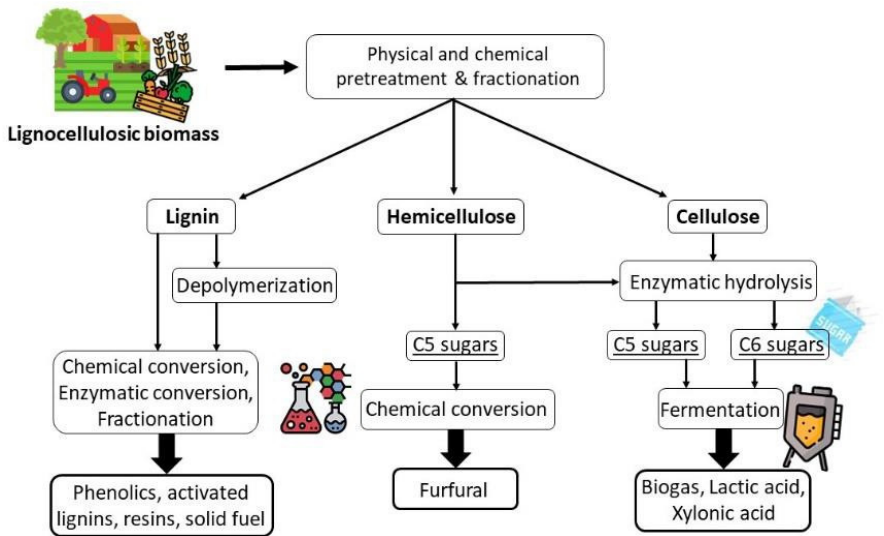
Figure 1. Biorefinery options for lignocellulosic biomass valorisation: a flowchart.